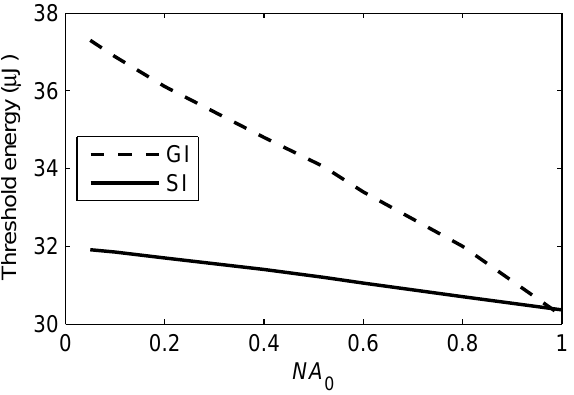
Figure 8. Lasing threshold pump energy at 581 nm as a function of the numerical aperture at the axis of the fiber: SI (solid line) and GI POFs with γ = 1.43 (dashed line). Parameters as in Table